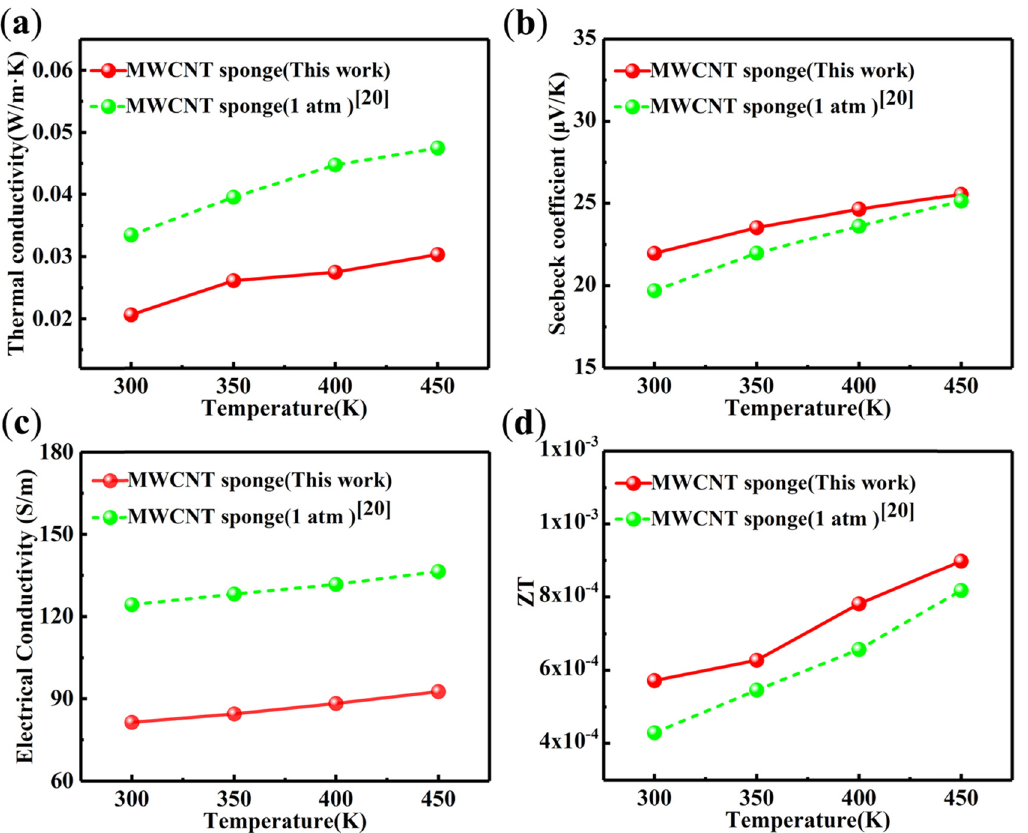
Figure 5: Temperature dependence of ( a ) thermal conductivity; ( b ) Seebeck coe ffi cient; ( c ) conductivity; ( d ) ZT ; of the MWCNT